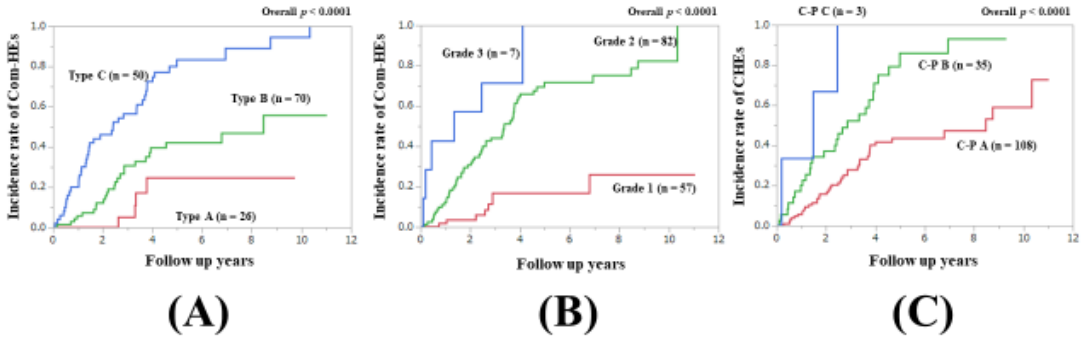
Figure 2. Cumulative incidence rates of composite hepatic events in patients aged 67 years or older (median value in our cohort, n = 146). ( A ) Serum Zn level grading system. ( B ) ALBI grading system. ( C ) Child–Pugh classification.